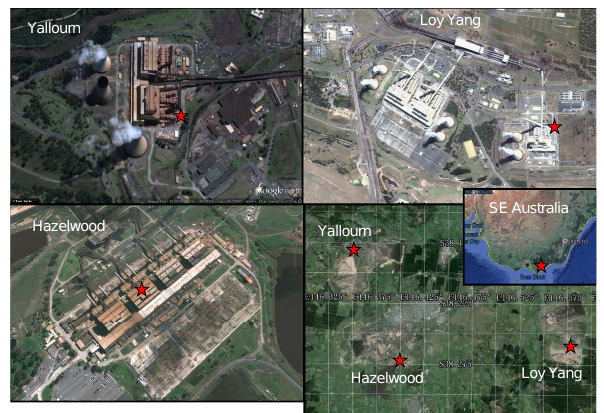
Fig. 7. The locations and aerial photos of the three coal power plants in the La Trobe Valley, Australia. The stars mark the base of the chimneys in the three zoomed-in photos. The power genera- tion capacity is 1450MW for Yallourn, 1600MW for Hazelwood, and 3250MW for Loy Yang.